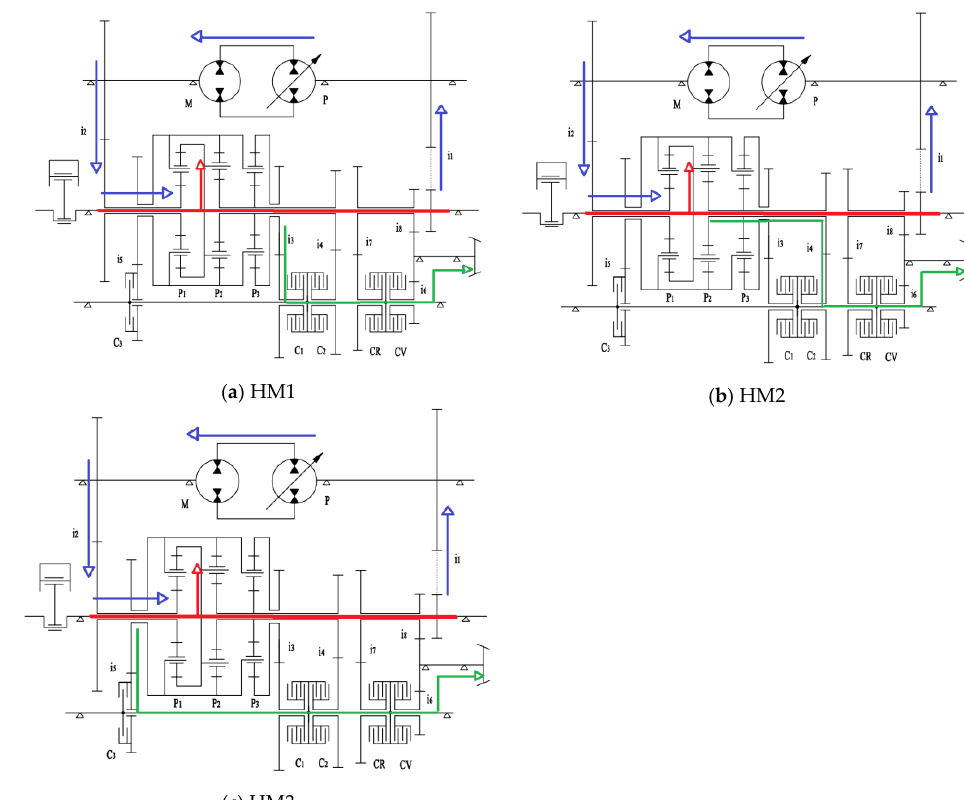
Figure 2. Power transmission route of HMCVT forward sections.